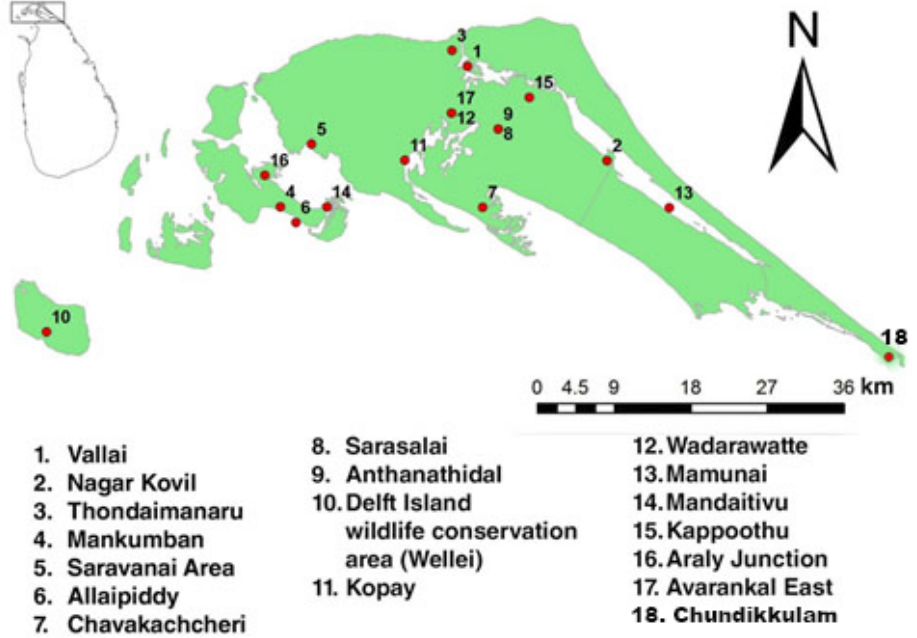
Figure 2: Map of Jaffna Peninsula showing the locations of major flocks of Greater